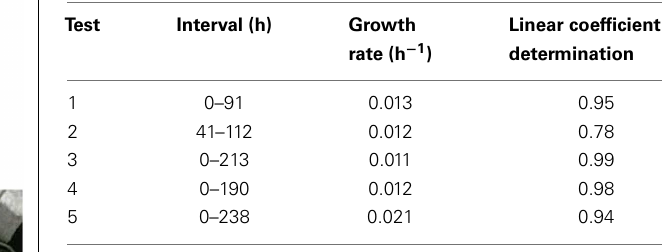
Table 5 | Selected productivity rates